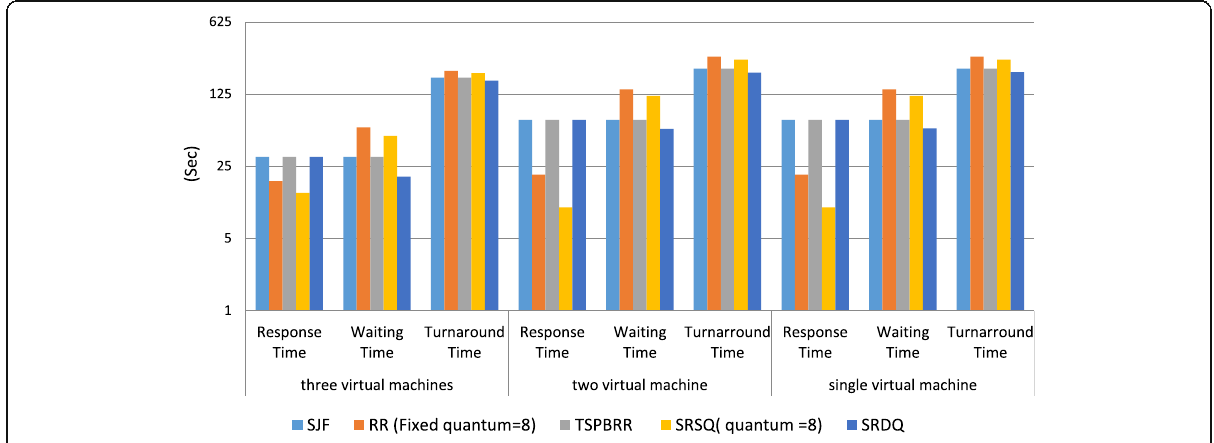
Fig. 1 First Experimentation Results using Dataset1, on (1, 2, 3)